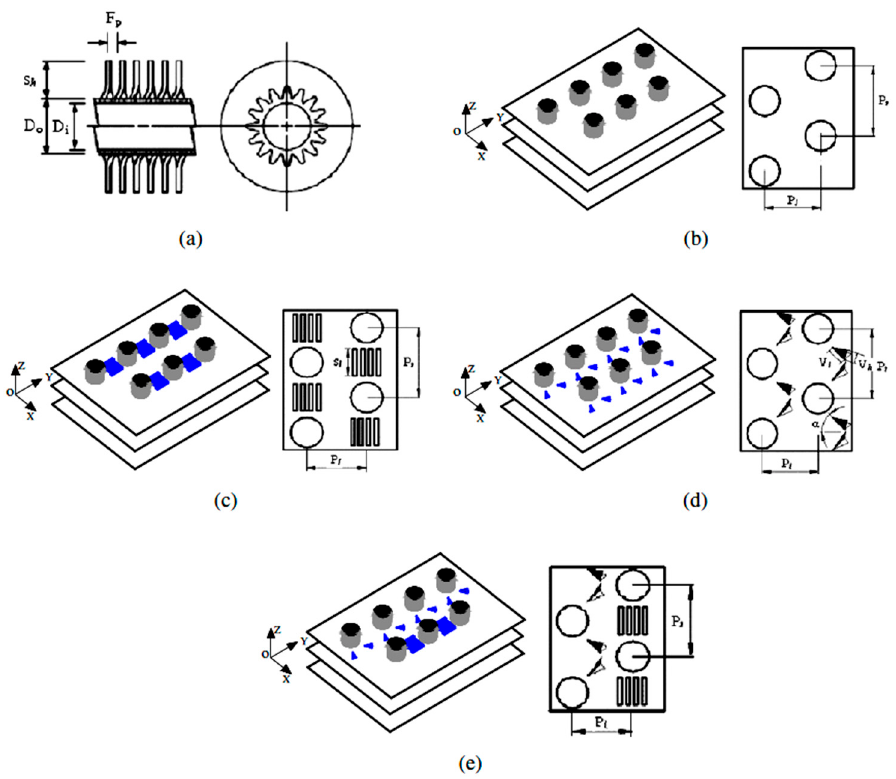
Figure 12. Different fin configurations tested by Tang et al. [48]. ( a ) Crimped spiral fin. ( b ) Plain fin. ( c ) Slit fin. ( d ) Vortex-generator fin. ( e ) Mixed fin.